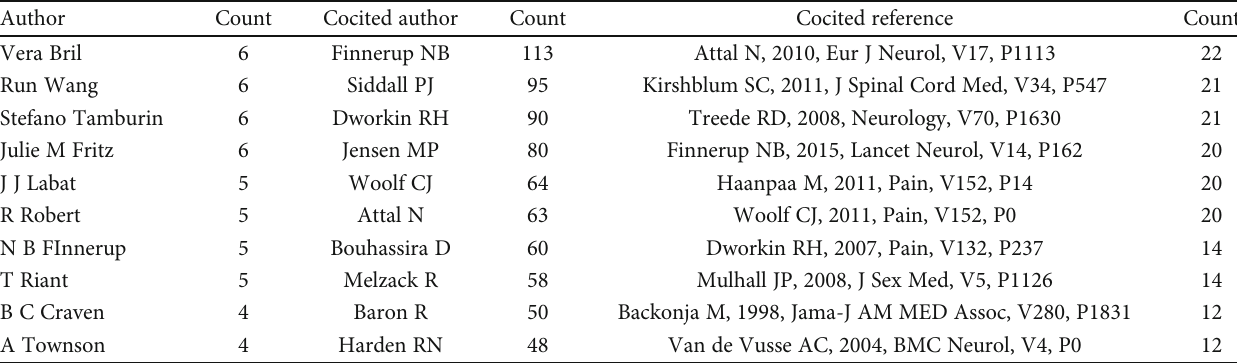
Table 3: The top 10 authors, cocited authors, and cocited references in neuropathic pain rehabilitation